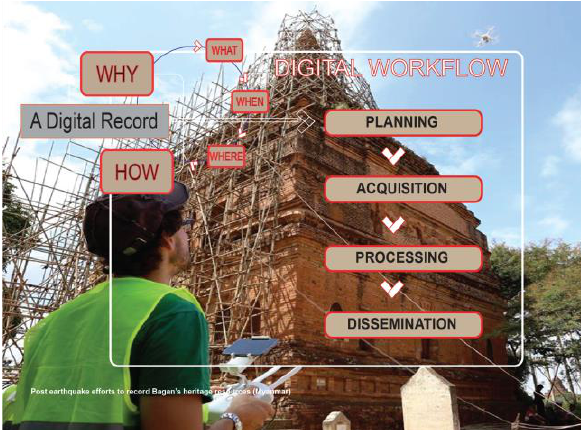
Figure 7: digital workflow to produce a